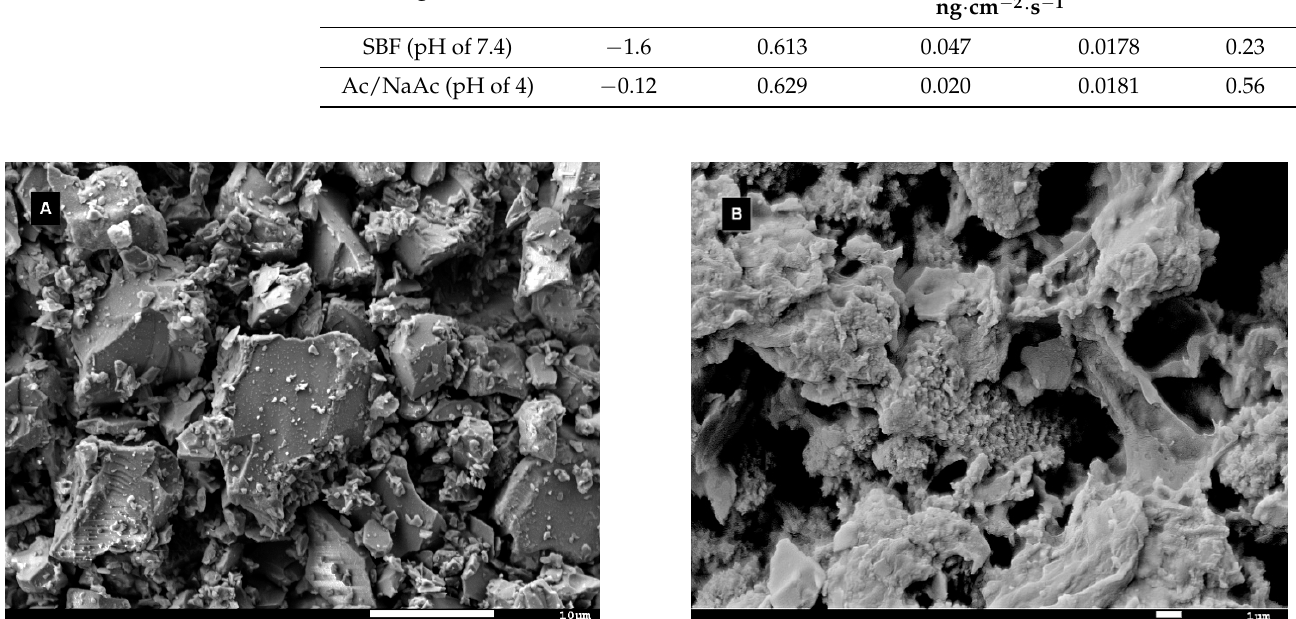
Figure 9. SEM micrographs ( A ) of VB glass powder before ( B ) testing and after the flow-through test in the SBF at a pH of 7.4.